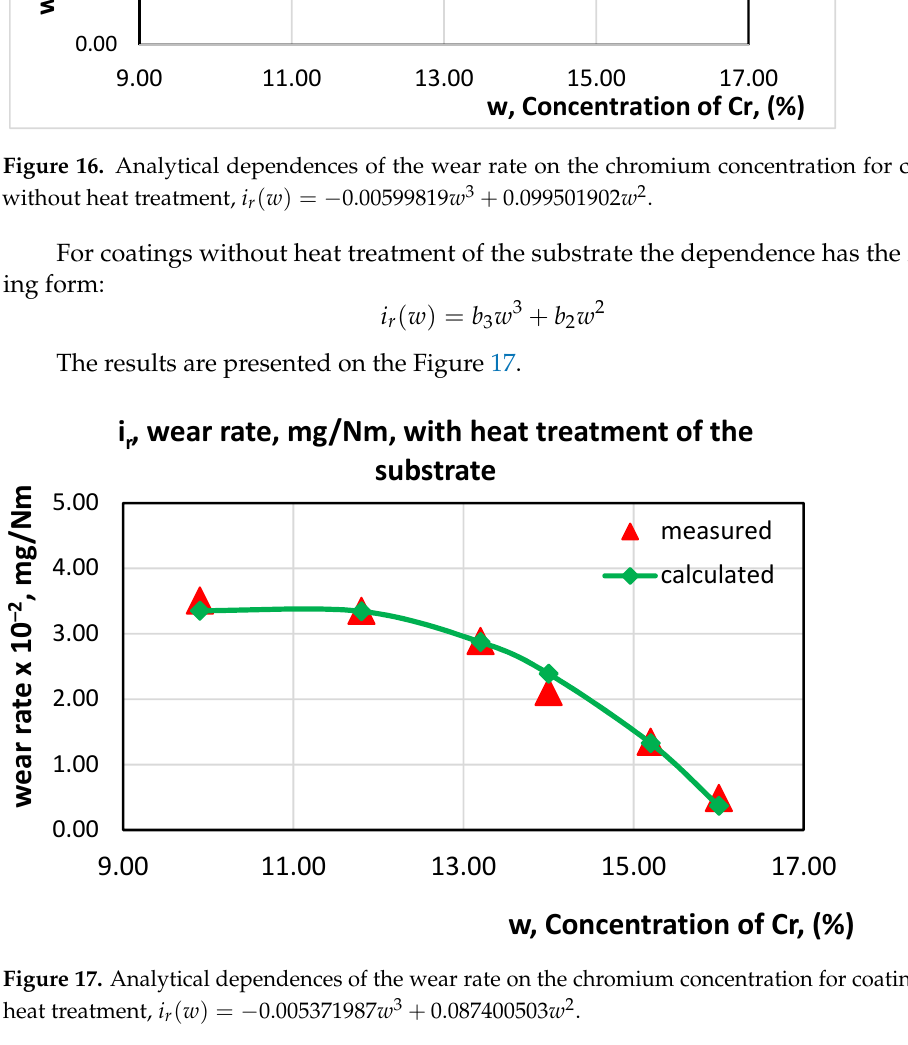
Figure 17. Analytical dependences of the wear rate on the chromium concentration for coatings with heat treatment, i r ( w ) = − 0.005371987 w 3 + 0.087400503 w 2 .